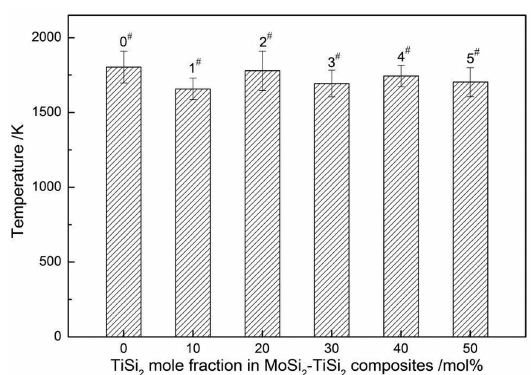
Figure 4. The combustion temperature – time curve for specimen 1 # , 2 # , 3 # , 4 # and 5 # .